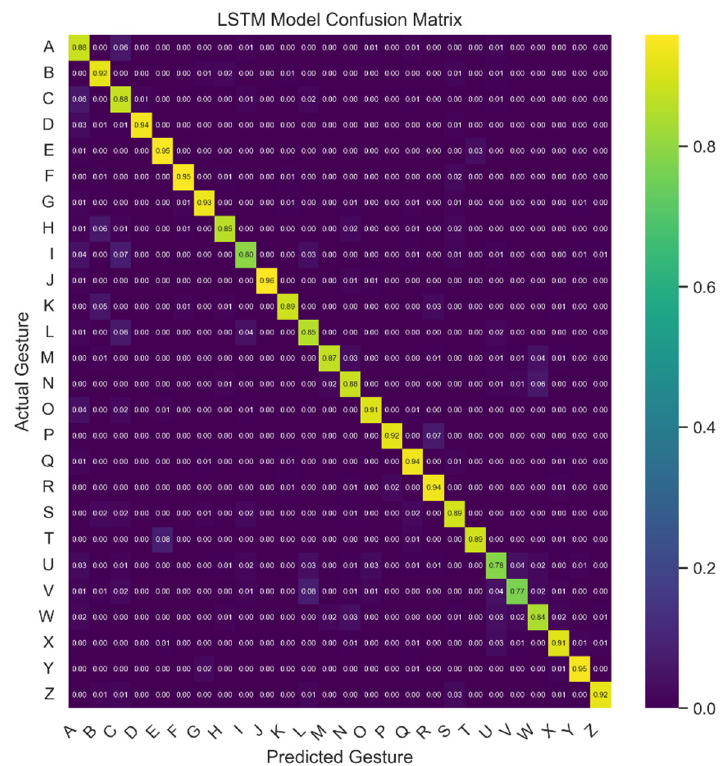
Figure 11. Confusion matrix generated using the LSTM algorithm.